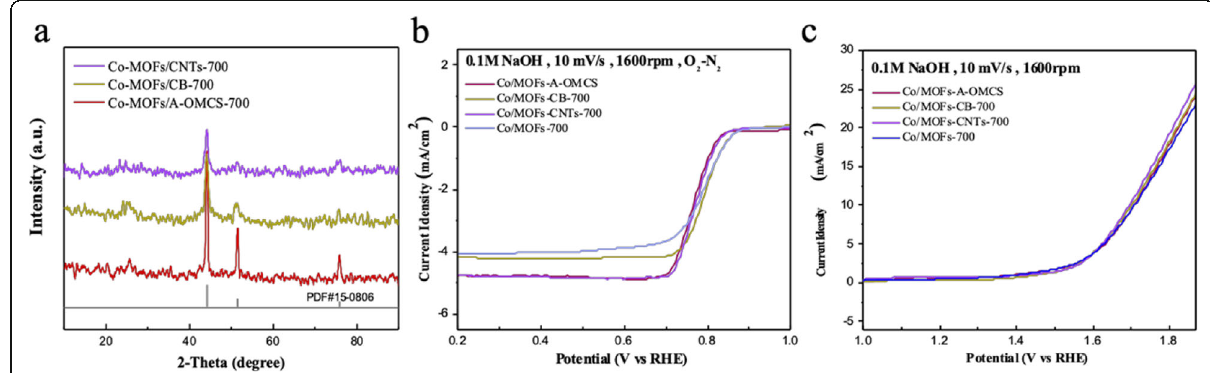
Fig. 6 a XRD patterns of doping different contents of carbon source into Co-MOFs. b , c ORR and OER polarization curves of Co/MOFs-700, Co/ MOFs-CNTs-700, Co/MOFs-A-OMCS-700, and Co/MOFs-CB-700, respectively